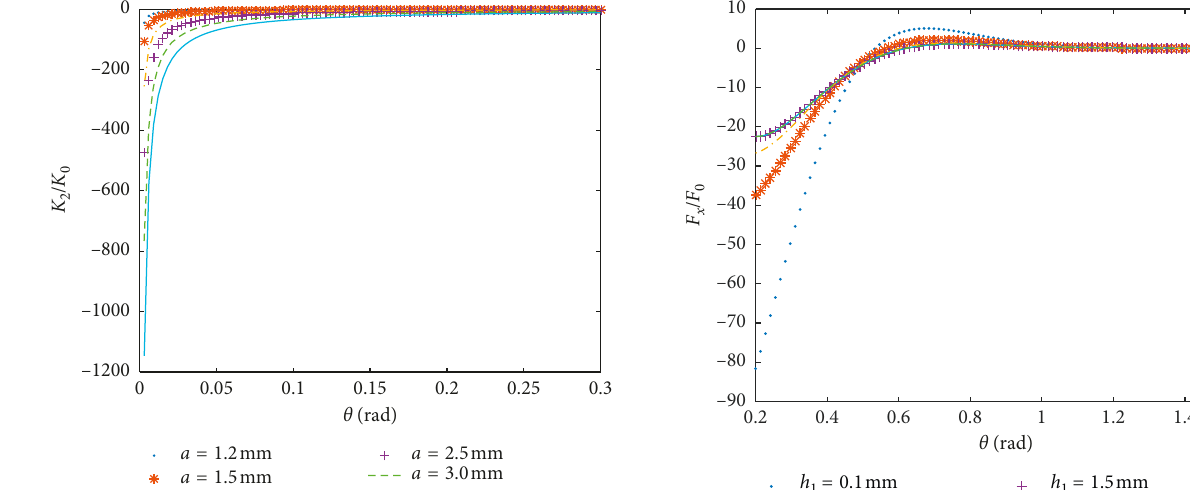
and angle θ for different 2